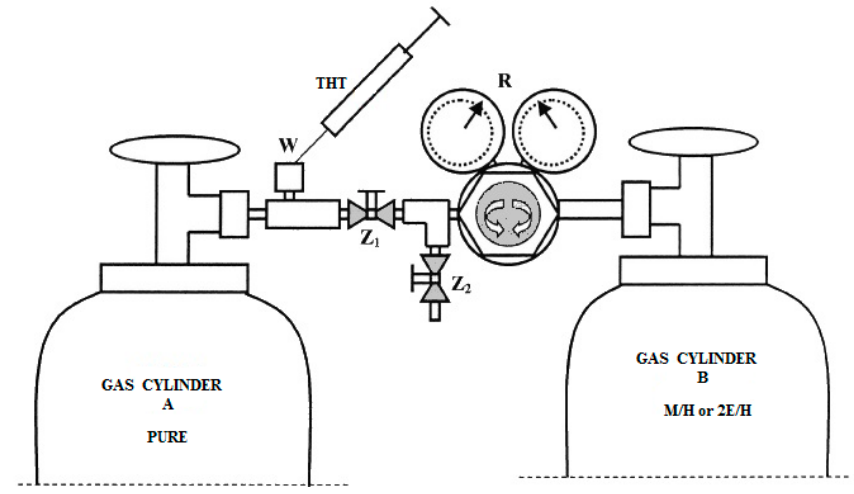
Figure 1. Diagram of connections between bottles: Z 1 —stop valve, Z 2 —relief valve, W—bottle connector with a dispenser, R—two-stage pressure regulator HP2.